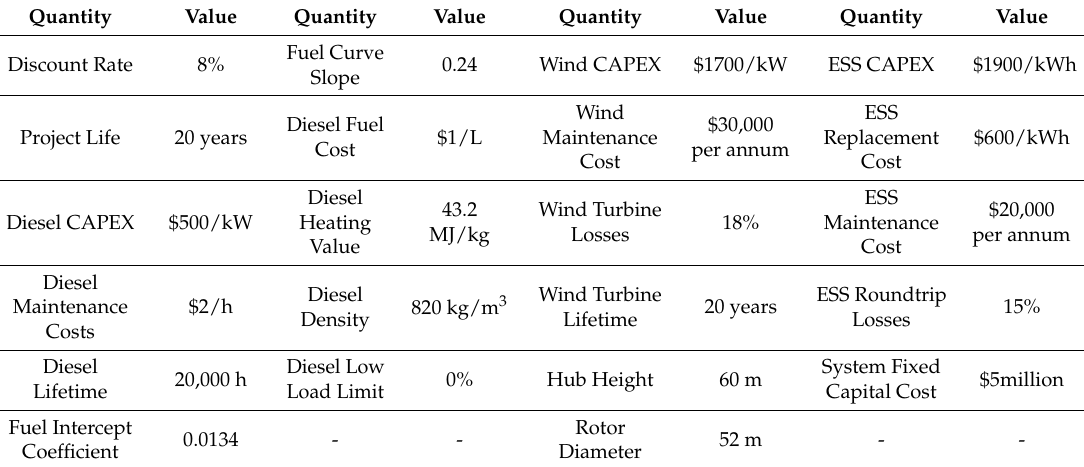
Table 1. Economic model